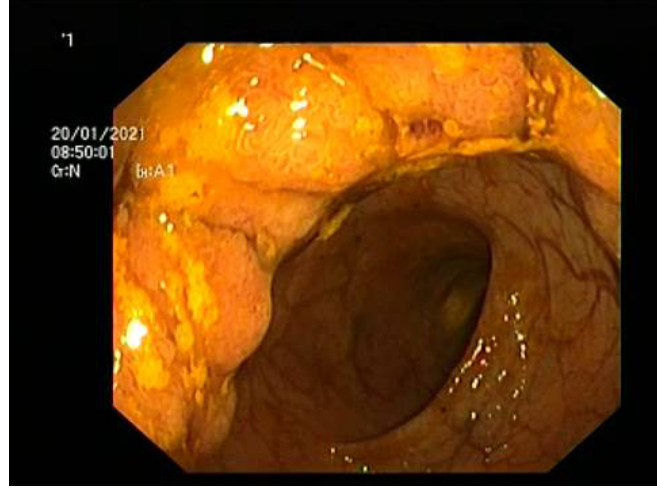
Figure 2. Tumoral mass identified at colonoscopy.